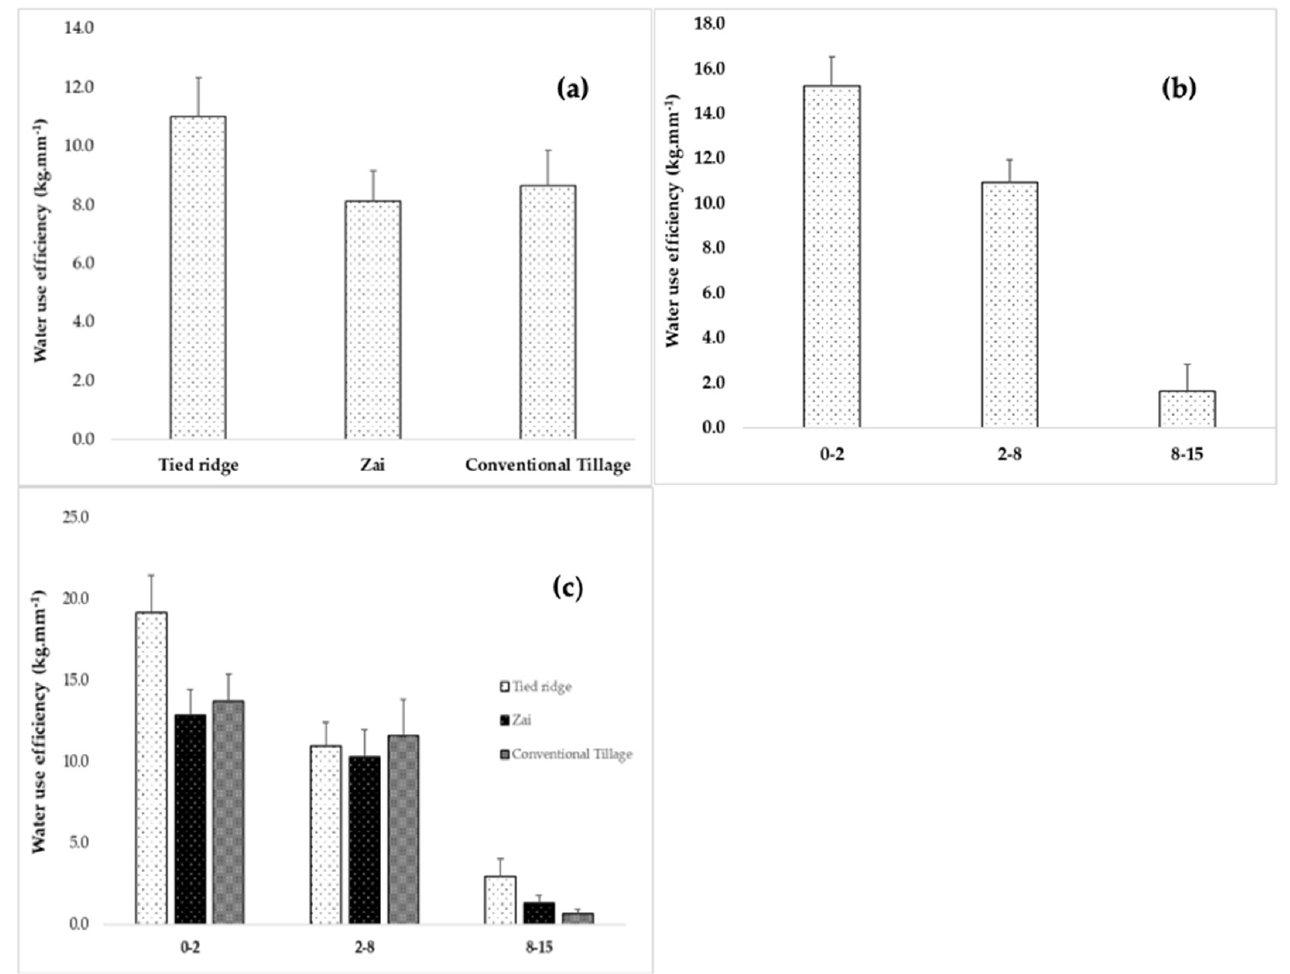
Figure 5. SWC practices ( a ) , slope gradient ( b ), and slope × SWC practices interaction effects ( c ) on water use efficiency in the Ruzizi Plain, eastern DRC.